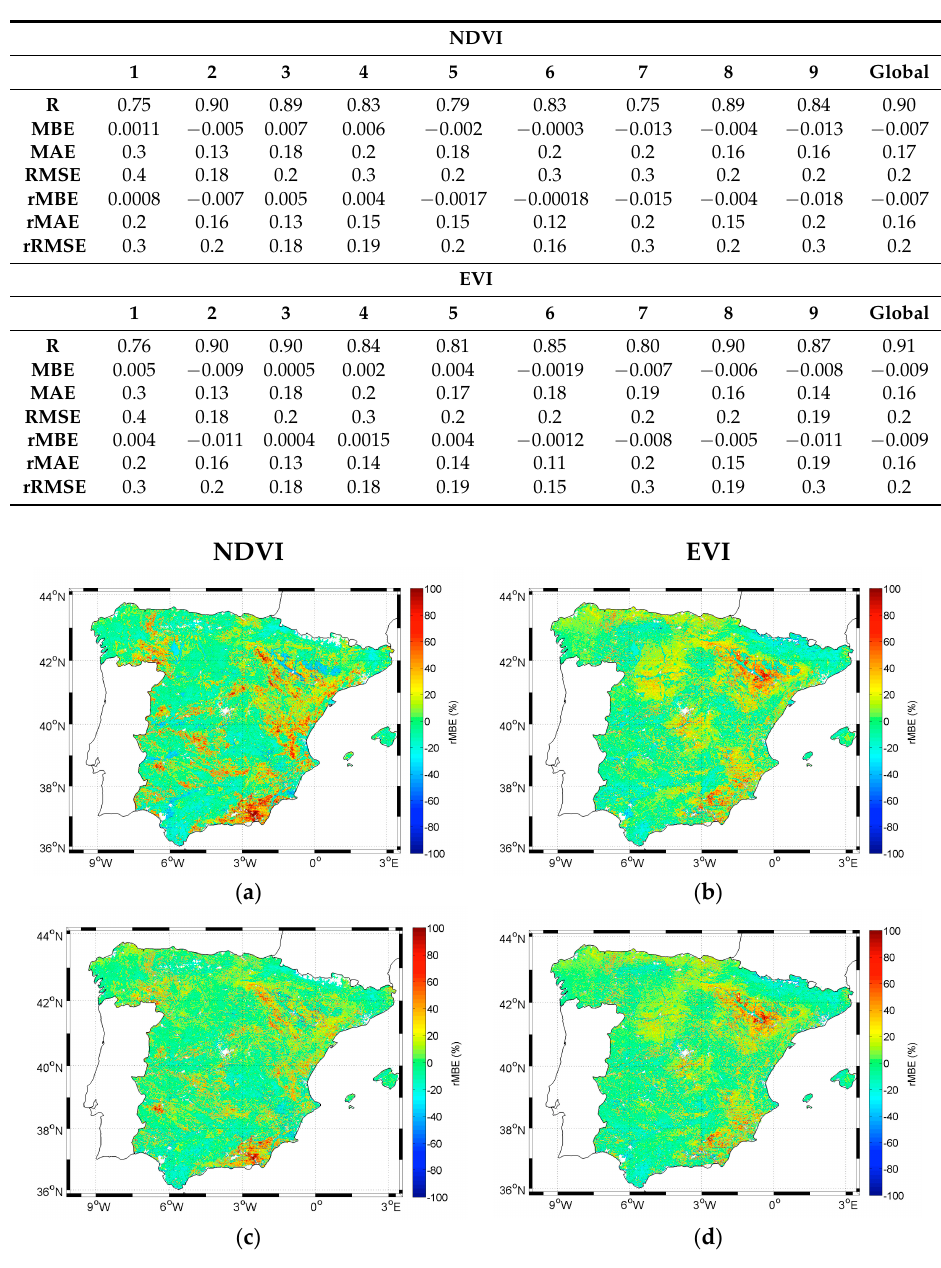
Figure 6. Mean rMBE (%) image showing the spatial distribution of the discrepancies between the estimated and the reference annual GPP: ( a ) Estimated annual GPP using the semi-empirical model with NDVI and with constant values of C 1 and C 2 ; and ( c ) considering C 1 and C 2 as a function of the land-cover type. ( b ) Estimated annual GPP using the semi-empirical model with EVI and with constant values of C 1 and C 2 ; and ( d ) considering C 1 and C 2 as a function of the land-cover type (red colors correspond to overestimates and blue color to underestimates).